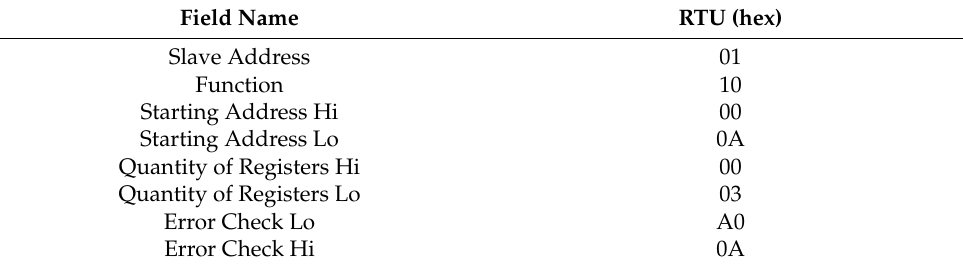
Table A3. Response from charger to Write Multiple values.